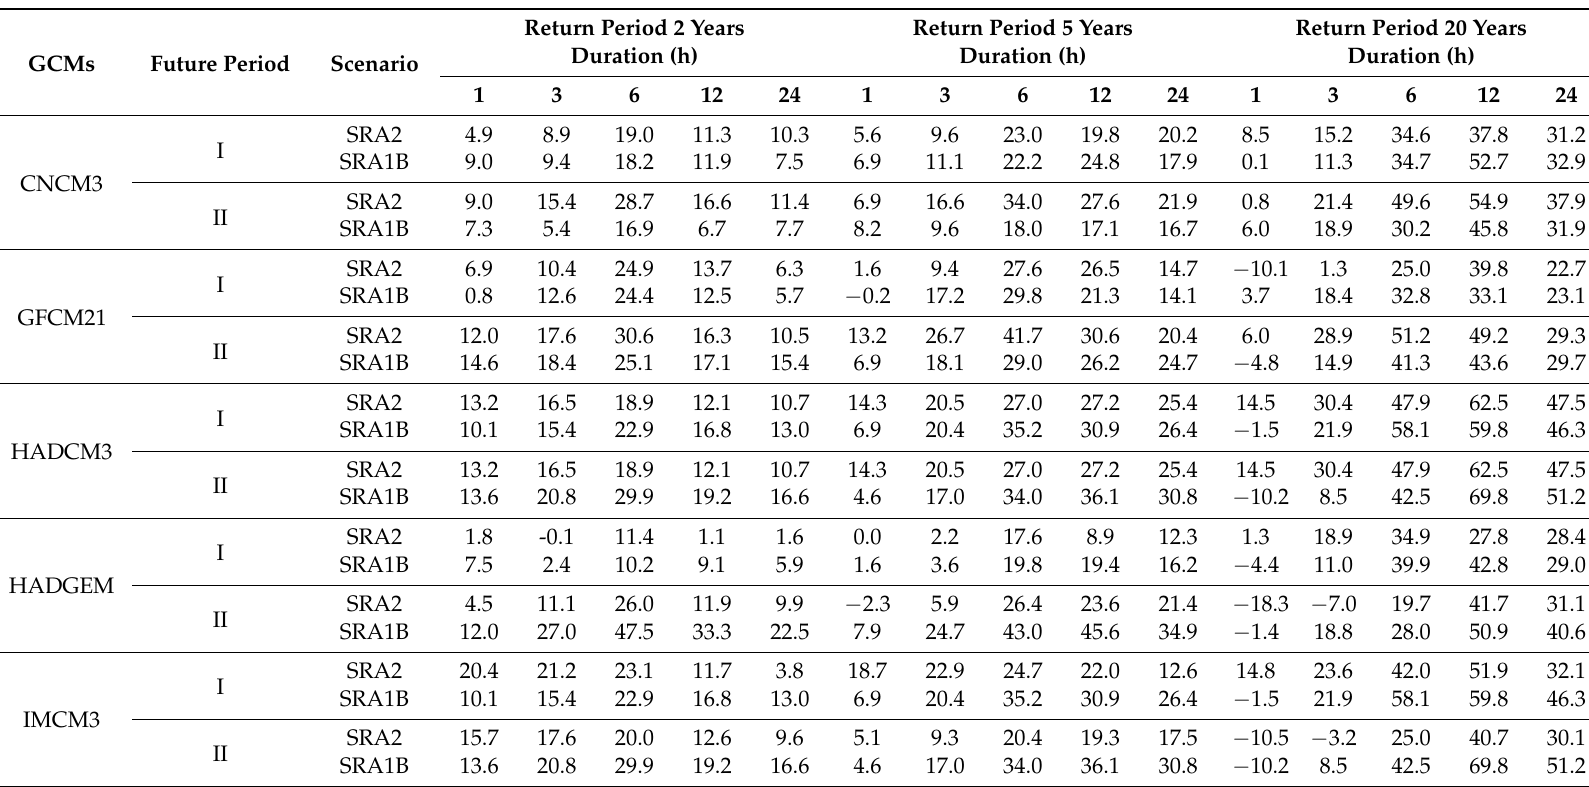
Table 5. Percentage change (%) of rainfall intensities at 2-, 5-, and 20-years return periods in 1 h, 3 h, 6 h, 12 h and 24 h durations from baseline 1981–2010 to future scenarios of 2011–2030 (I) and 2046–2065 (II)